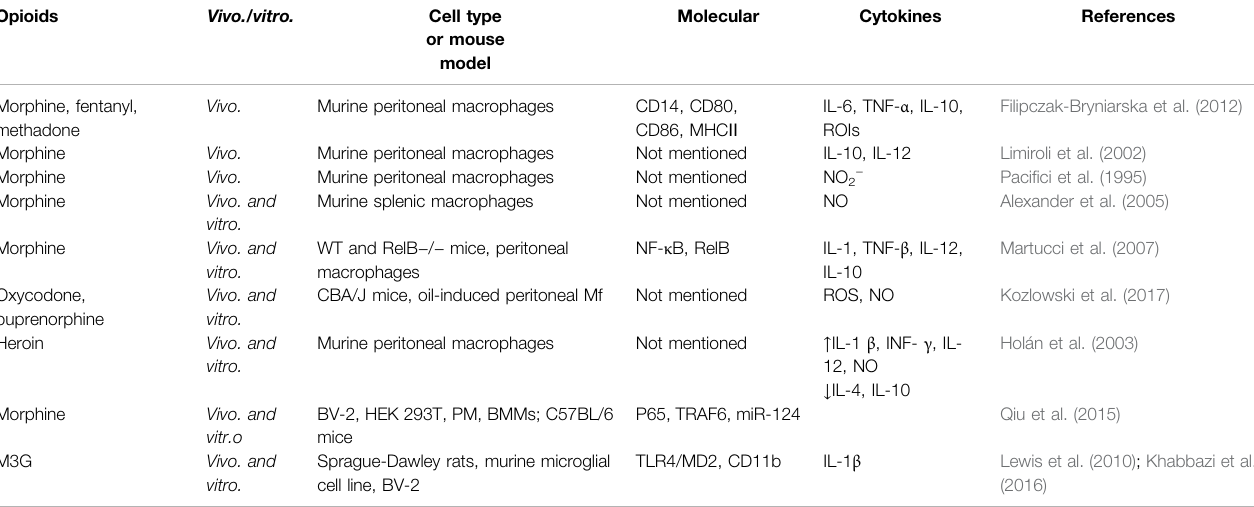
TABLE 2 | Opioids affect the molecular targets of macrophages and the production of various cytokines. Opioids